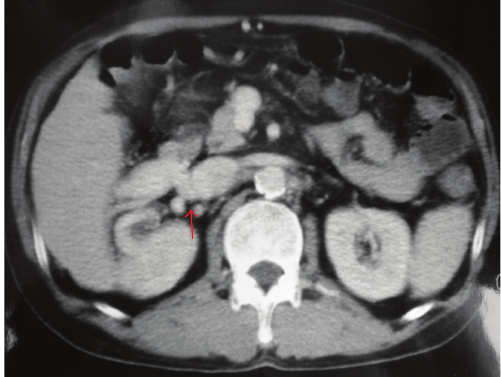
Figure 1: Computed tomographic findings. The portosystemic shunt (arrow) can be seen above the right kidney.